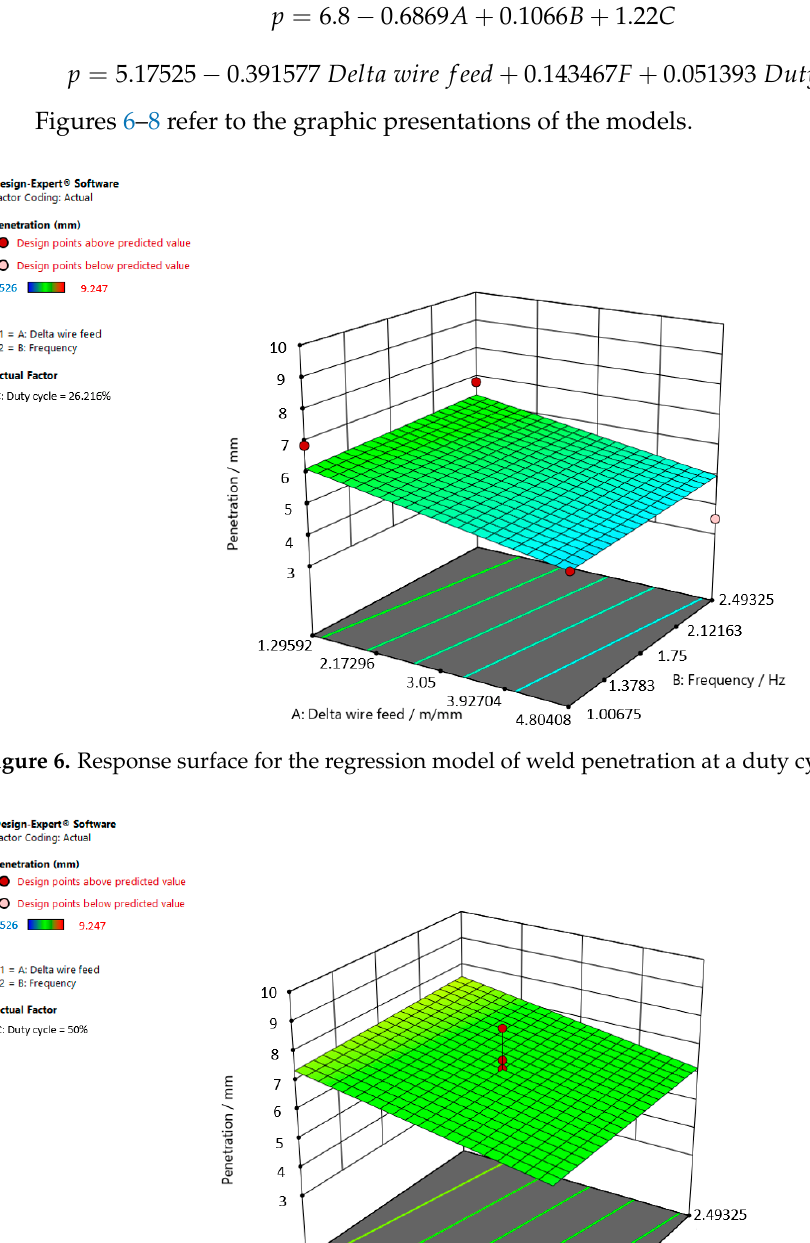
Figure 8. Response surface for the regression model of weld penetration at a duty cycle of 73.78%. Figure 8 shows that the superelevation in the weld increases and the delta wire feed parameter decreases when the duty cycle is 73.78%. 3.3. Output Variable—Weld Width The linear model again proved to be the best for the experimental data. The models were tested for the mean squared deviation, lack of fit, and coefficients of determination, and the obtained data are shown in Table 12. Table 12. Simulation of four models in the design expert weld width.